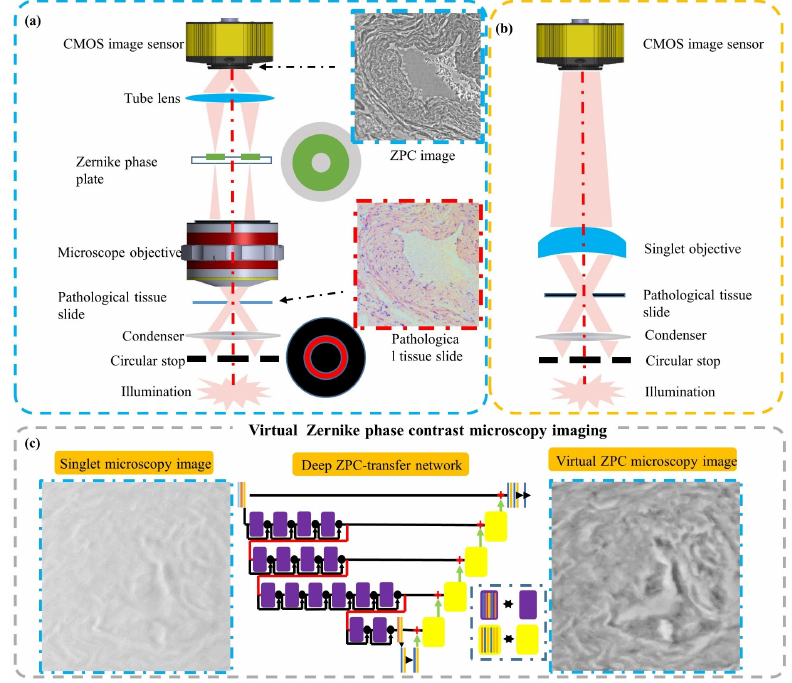
Figure 18. Singlet virtual phase-contrast microscopy. [108]: ( a ) a 2D schematic of a traditional Zernike phase contrast microscopy setup, ( b ) a 2D schematic of a singlet phase contrast microscopy setup, and ( c ) Deep ZPC-transfer network